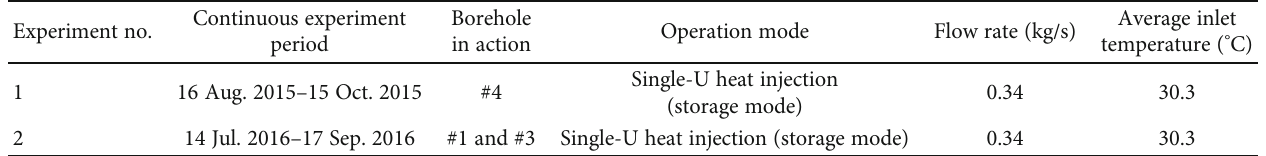
Table 2: Experimental conditions.